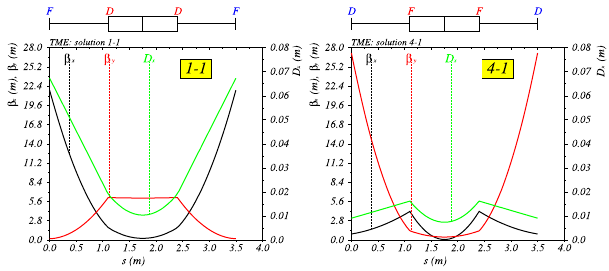
FIG. 11. Optical functions for model cells mTME (left) and TME (right).